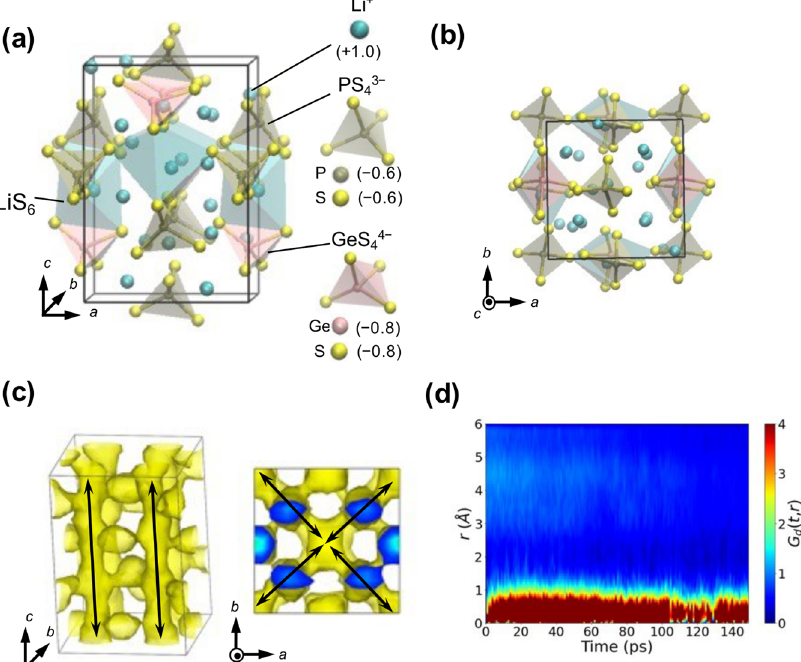
Fig. 2 Crystal structure and transport property of Li 10 GeP 2 S 12 . The equilibrated structure of 2 Li 10 GeP 2 S 12 (8.72 × 8.72 × 12.64 Å 3 ) obtained by NVT simulation at 1200 K: a side view and b top view. c Isosurface of Li-ion probability density distribution, and d the distinct part of the van Hove correlation function of the EMD as a function of Li – Li distance r and time t at 1200 K.